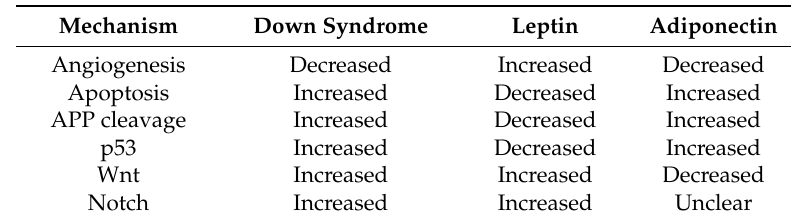
Table 1. Cellular and molecular mechanisms involved in the ds, obesity, Alzheimer’s disease and cancer relationships